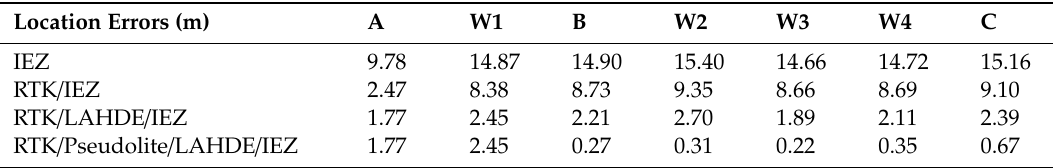
Table 2 . Comparison of location errors of Person A. Table 2. Comparison of location errors of Person A.